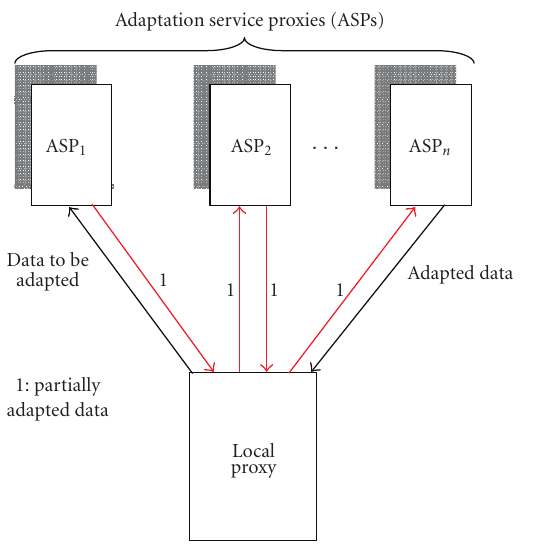
Figure 5: Centralized services execution pattern (star-based).